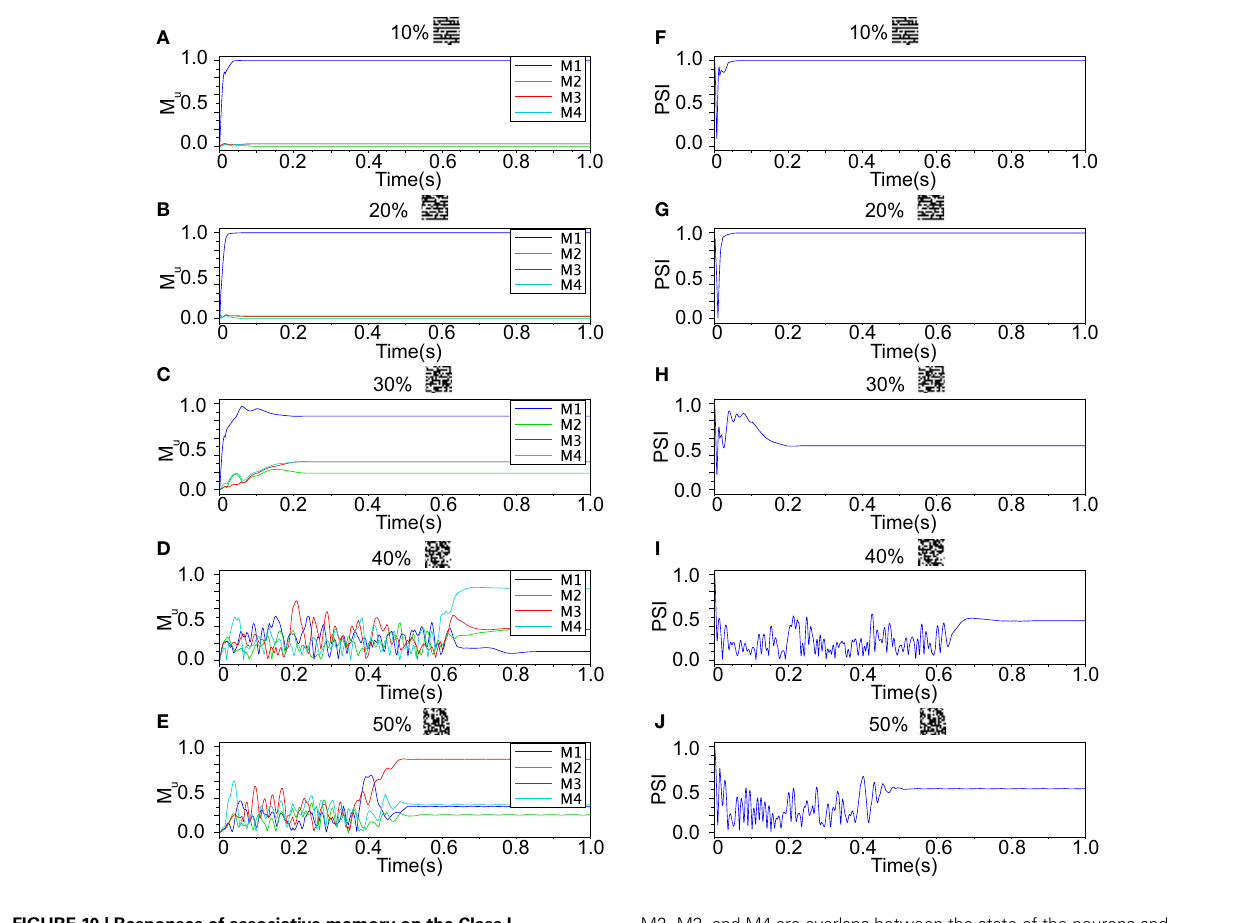
FIGURE 10 | Responses of associative memory on the Class I mode network when the patterns in Figure 8B was applied. Planes (A–E) show the overlaps when the input pattern contains from 10 to 50% errors. In each plane, four colored curves labeled as M1,